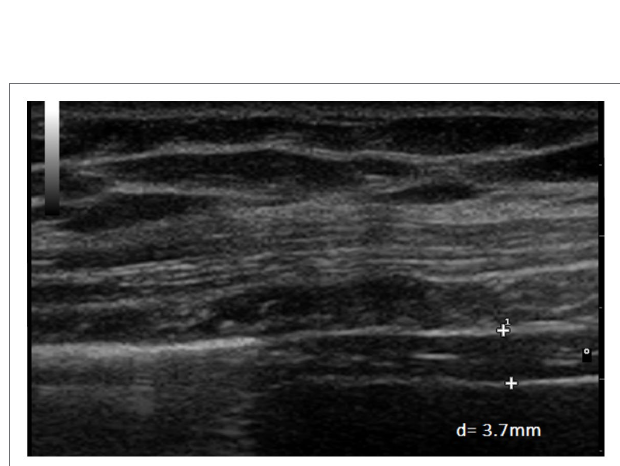
FIGURE 5 | Measurement of diaphragm thickness in one volunteer at end- inspiration without load (d = 2.9 mm).